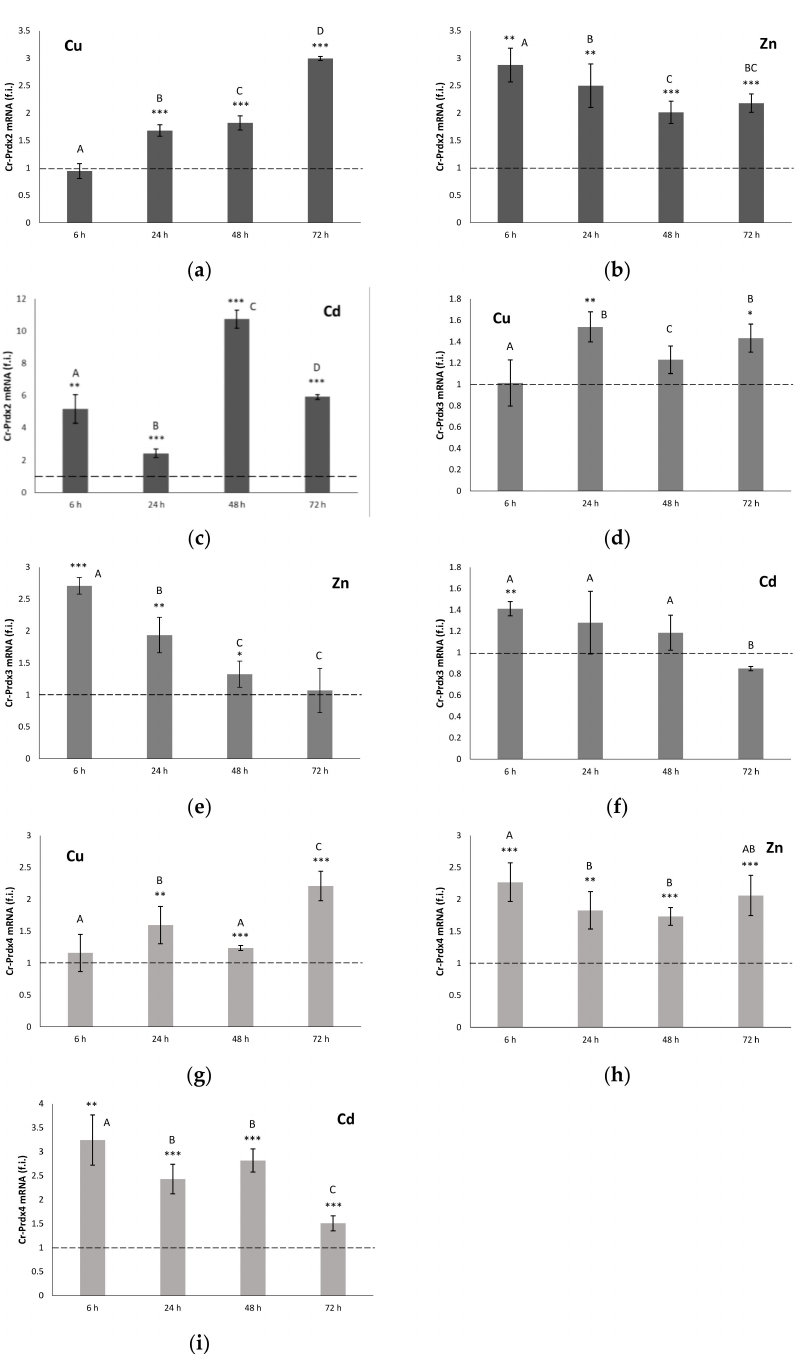
Figure 2. Relative expression levels (fold induction, f. i.) of Cr-Prdx2 ( a–c ), Cr-Prdx3 ( d–f ) and Cr-Prdx3 ( g–i ), during Cu, Zn and Cd exposure. Values are indicated as mean ± SD. Transcription levels were normalized with respect to controls (dashed line). Asterisks: significant differences with respect to controls (*** p < 0.001, ** p < 0.01, * p < 0.05). Different letters correspond to significant statistical differences ( p < 0.05) among different treatment times (Duncan’s